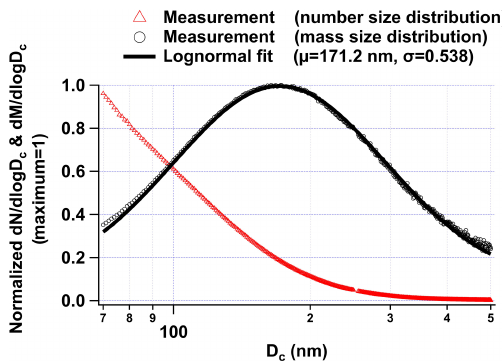
Figure 4. Number and mass size distribution (d N / dlog D c and d M / dlog D c ) during the observation